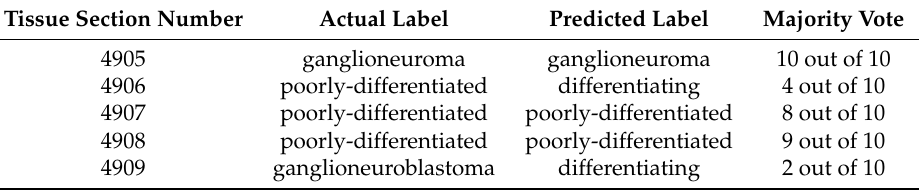
Table 8. The actual and predicted labels for dataset from University of Bristol.